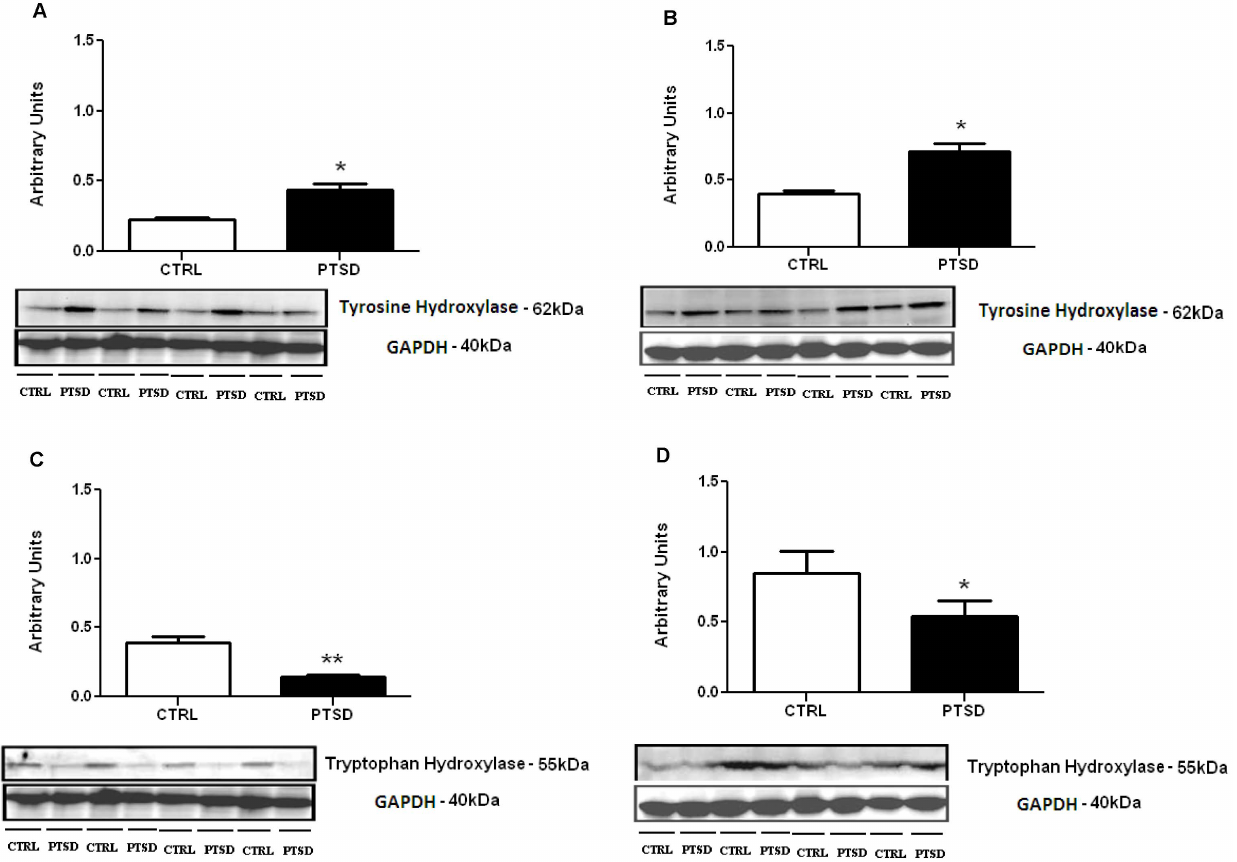
Figure 3. Rate-limiting enzymes tyrosine hydroxylase (catecholamines) and tryptophan hydroxylase (5-HT) post-stress. Tyrosine hydroxylase elevation in the PFC (A) and hippocampus (B) substantiated the findings of elevated levels of NE and DA, while down-regulated tryptophan hydroxylase in the PFC (C) and hippocampus (D) confirmed decreased levels of 5-HT. All data are presented as mean 6 SEM. *p , 0.05, **p , 0.001.